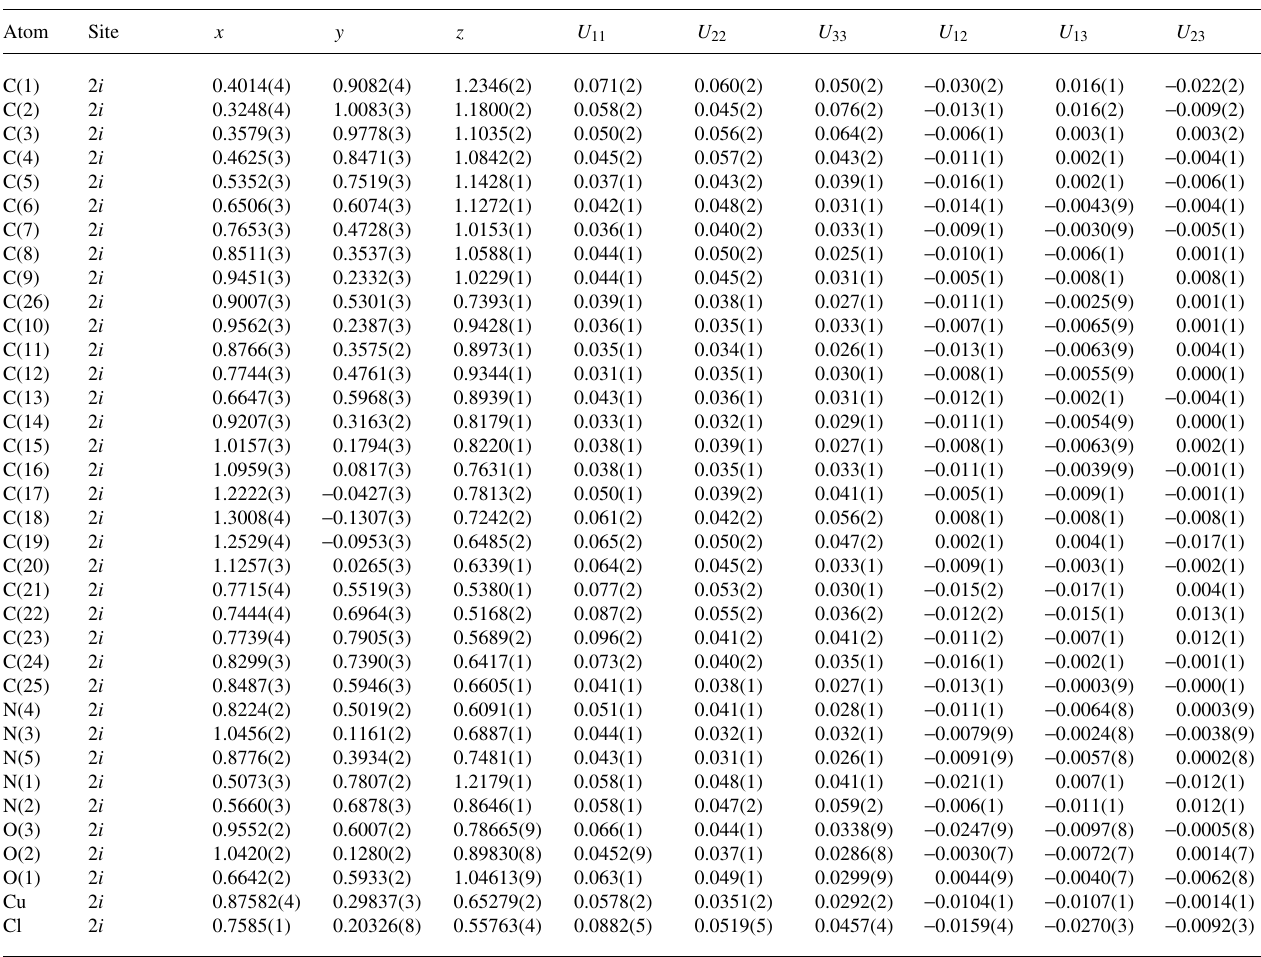
Table 3. Atomic coordinates and displacement parameters (in Å 2 )